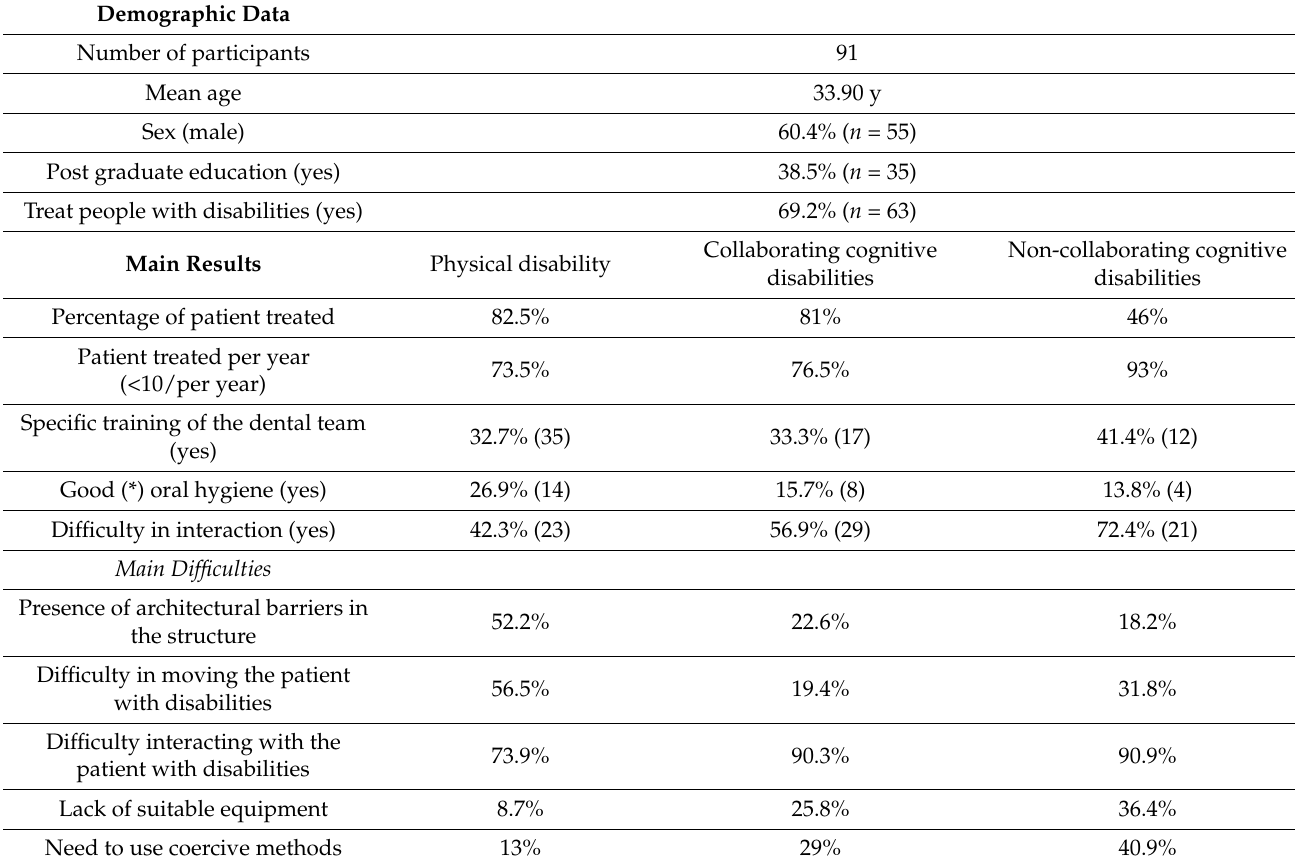
Table 1. Summary table of demographic data and main results obtained by administering questionnaires to dentists. (*) Good oral hygiene was established by the common index used daily for patient monitoring. Demographic